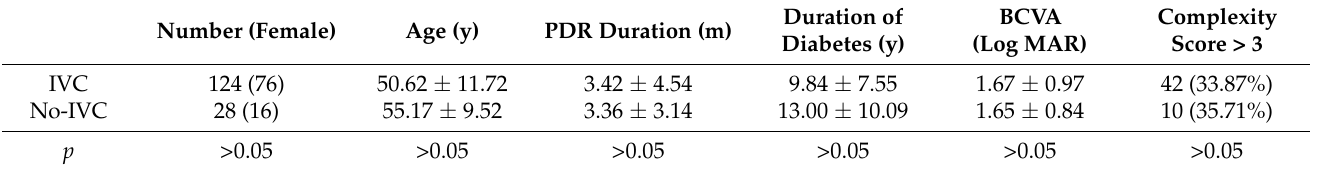
Table 1. Comparison of preoperative baseline data (x ±